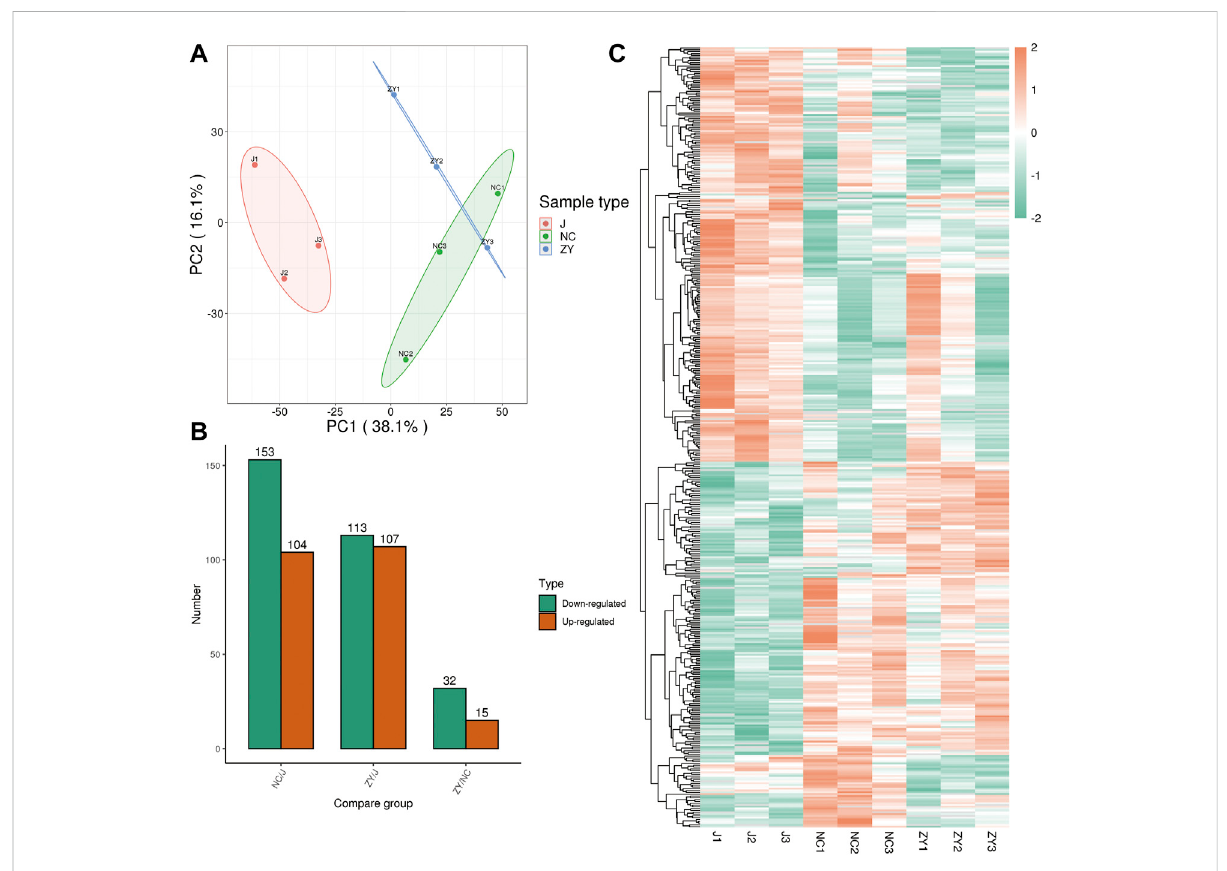
FIGURE 2 4D label-free quantitative proteomics analysis of differentially expressed proteins (DEPs) among the different groups. (A) PCA score plots of proteome data. (B) Number of DEPs between each group. (C) Heat map of DEPs between each group.